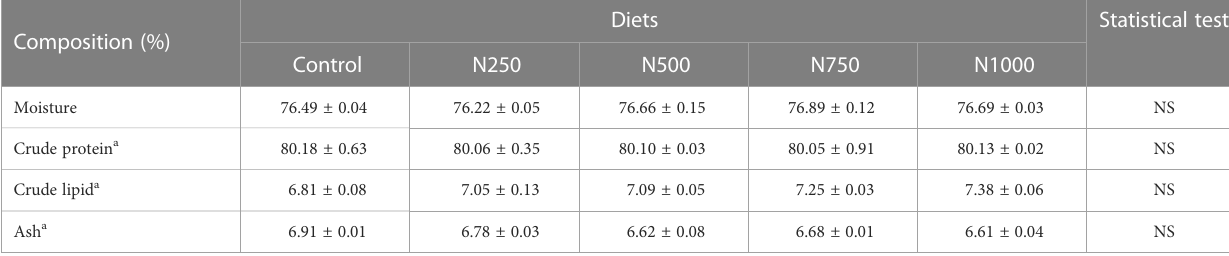
TABLE 4 Proximate analysis of muscle samples from white shrimp fed dietary treatments for 6